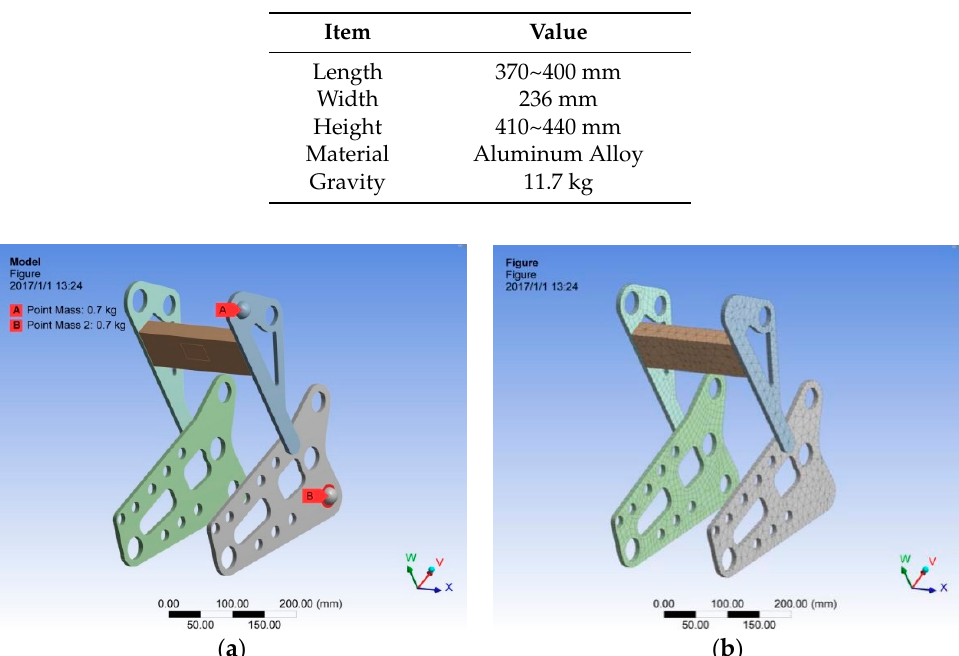
Table 1. The parameters of the robot.